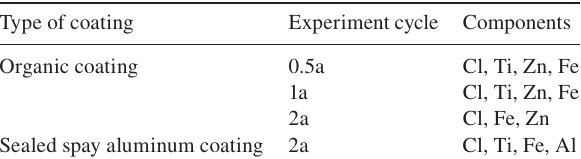
Table 1 Results of EDS analysis.